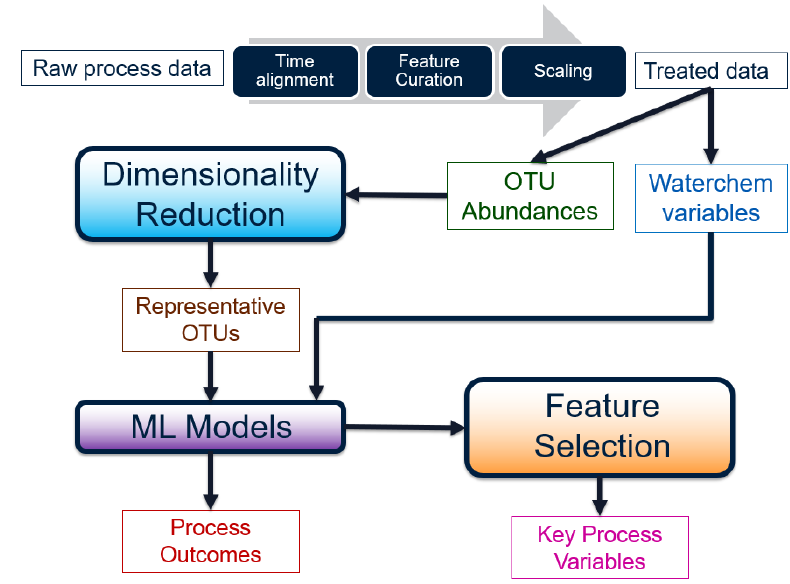
Figure 3. Workflow of the pre-processing, dimensionality reduction, modeling, and feature selection steps. The final goal is to transform the input data into predicted outcomes, as well as key variables responsible for said